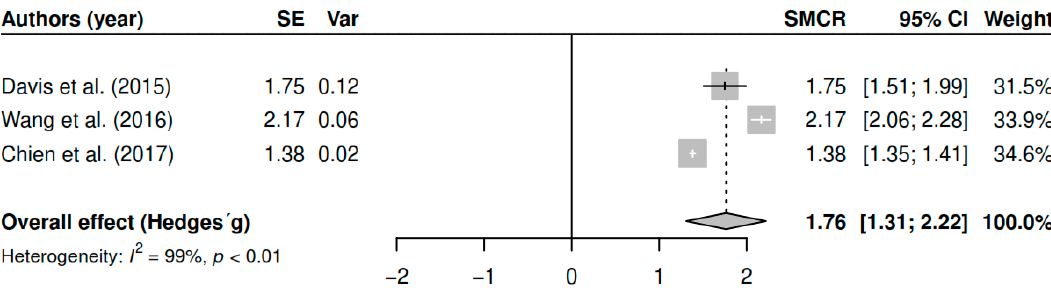
Figure 2. Forest plot for the model of random-effects and the values of Hedges’ g statistics in the overall symptomatology variable (pretest–posttest).